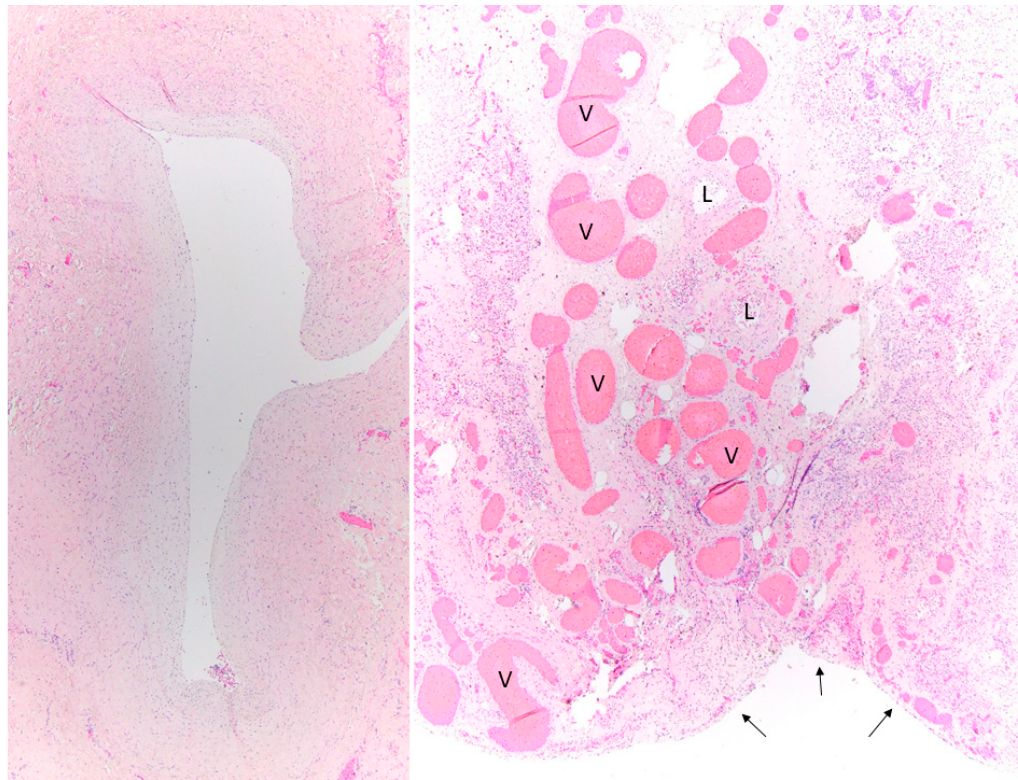
Figure 2. Histologic findings in pulmonary vein stenosis. After death at age 13 months, this patient’s pulmonary veins showed fibrous intimal proliferation (left panel; hematoxylin and eosin; original magnification, 40 × ). The pleura (arrows) and interlobular septum were thickened, containing distended and tortuous veins (V) and thick-walled lymphatic channels (L) (right panel; hematoxylin and eosin; original magnification, 100 ×